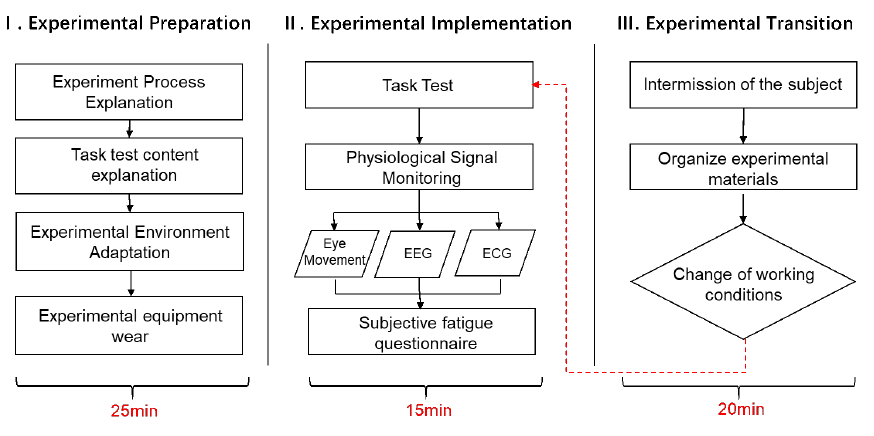
Figure 5. Experimental